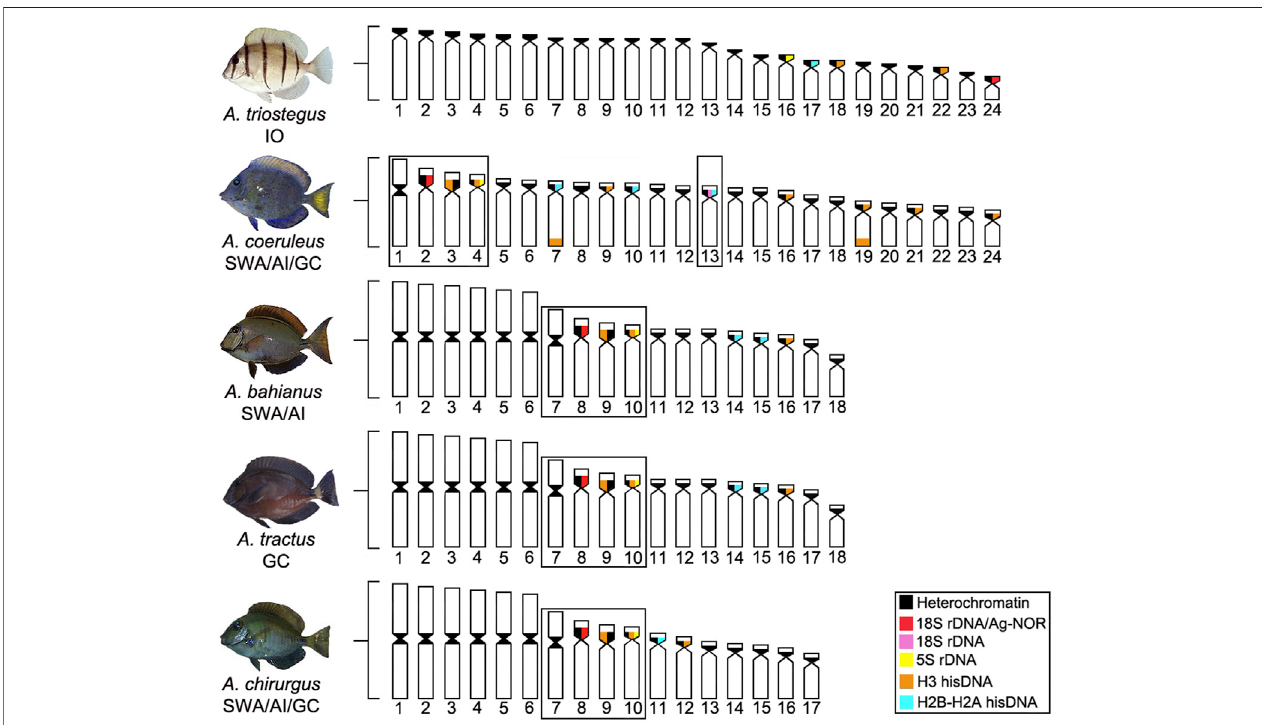
FIGURE4| IdeogramshowingtheorganizationofdifferentclassesofrepetitiveDNAs(rDNAandhisDNA)in fi vespeciesandpopulationsof Acanthurus .Theboxes highlight a set of two-armed chromosomes shared by all Atlantic species. The dotted box highlights a chromosome pair bearing an extra 18S rDNA site in Southwest Atlantic individuals. GC, Greater Caribbean; SWA, Southwest Atlantic; IO, Indian